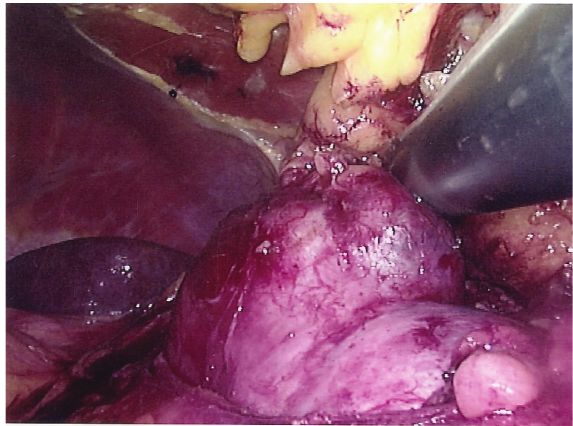
Figure 1: Ultrasound scanning of an exophytic left renal tumour exposed by laparoscopic mobilisation prior to